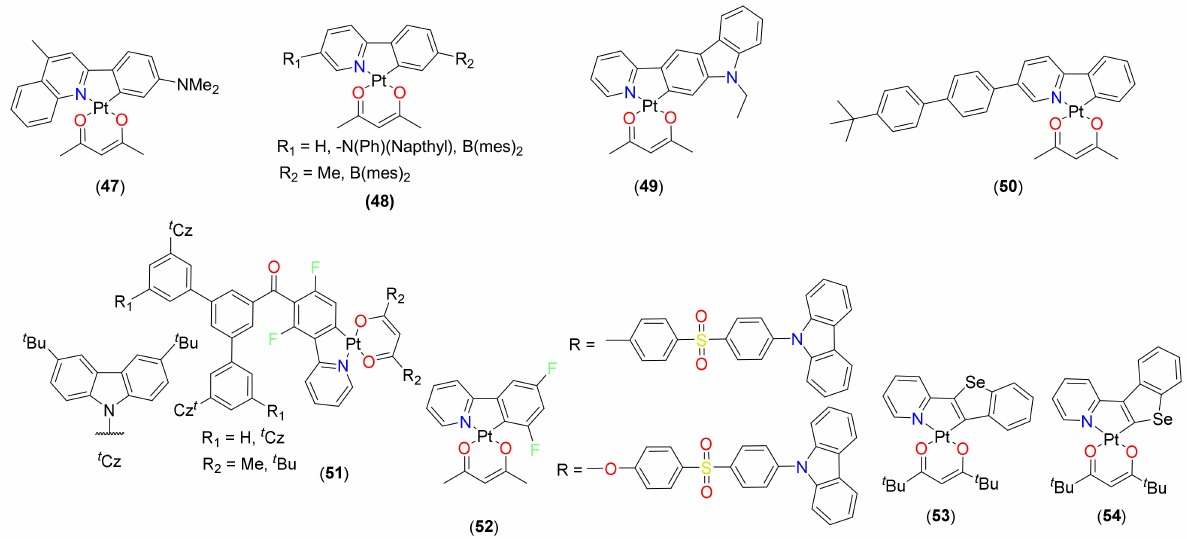
Figure 12. Cyclometalated Pt(II) complexes-based luminophores for OLEDs. In order to delineate the structural and electronic influences on the emission properties, Strassner and coworkers [18] reported thiazol-2-ylidene Pt(II) complexes based on the N- phenyl-4,5-dimethyl-1,3-thiazol-2-ylidene NHC ligand and seven different β -diketonate ligands. They found that complex 17 (R 1 = R 2 = Me; R 4 = R 5 = R 6 = H; R 3 = mes Figure 4) exhibits promising thermal stability, high quantum yields with a decay lifetime of 10.0 µ s and stable emission properties in neat films. Interestingly, the emission spectra of the complex were independent of the type β -diketonate ligand selected, which is quite sensitive in other (CˆC)Pt(OˆO) derivatives such as imidazole or triazole NHCs containing complexes. Under optimized condition, a mixed-matrix OLED device doped with 15% of complex 17 (R 1 = R 2 = Me; R 4 = R 5 = R 6 = H; R 3 = mes, Figure 4) showed EQE = 12.3%, LE = 24.0 lm/W and CE = 37.8 cd/A at 300 cd/m 2 with a green emission color. This performance was better than the previously reported CˆC* cyclometalated Pt(II) complexes [29,86]. For instance, CˆC* cyclometalated Pt(II) complexes 2 (R = duryl, Figure 2) based on imidazole NHC ligands and acac derivatives exhibited EQE 12.6%, LE = 11.9 lm/W and CE = 25.2